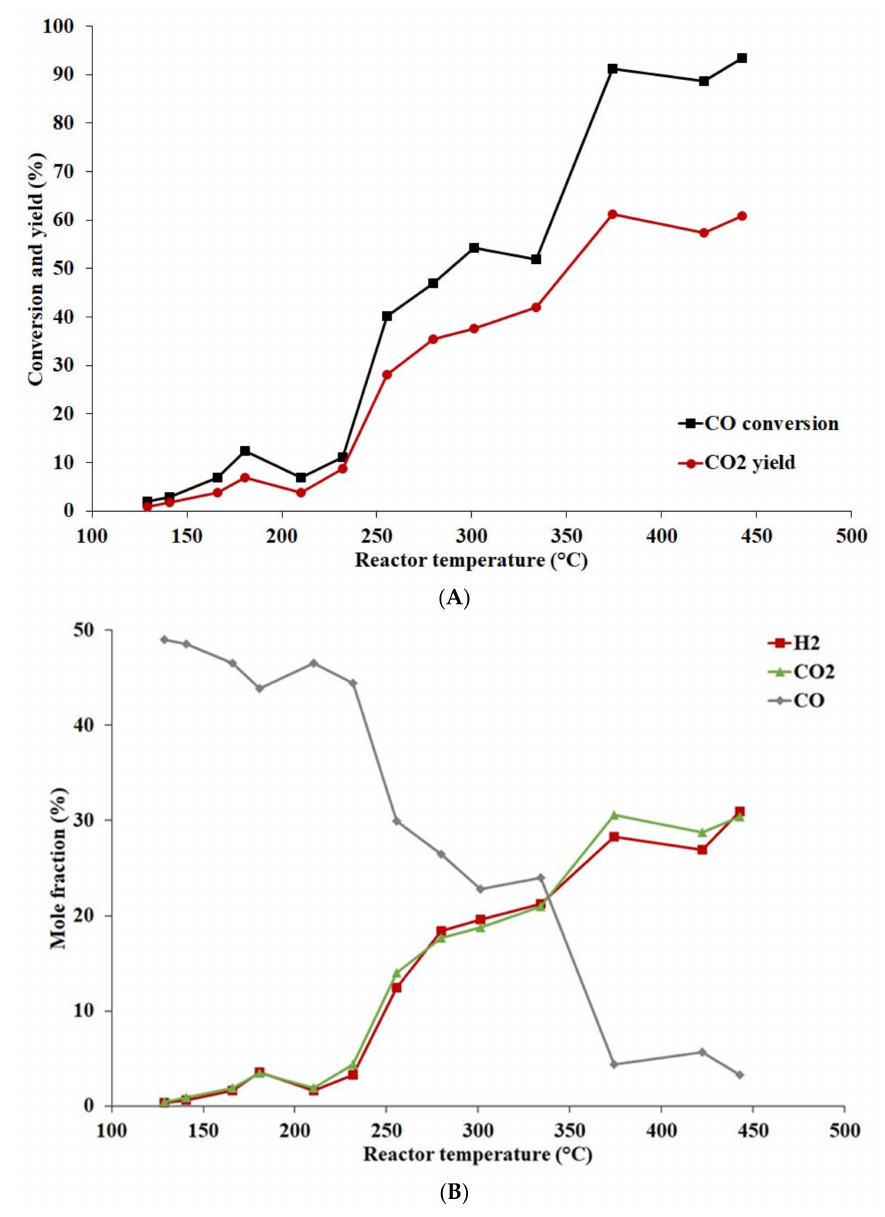
Figure 14. Catalytic tests on a Cu-based activated catalyst (47.6 wt%) prepared with calcined support with feed gas mixture 1 (50 mole% CO, 50 mole% N 2 ) at pressure 0.5 MPa: ( A )—CO conversion and CO 2 yield; ( B )—composition of the produced